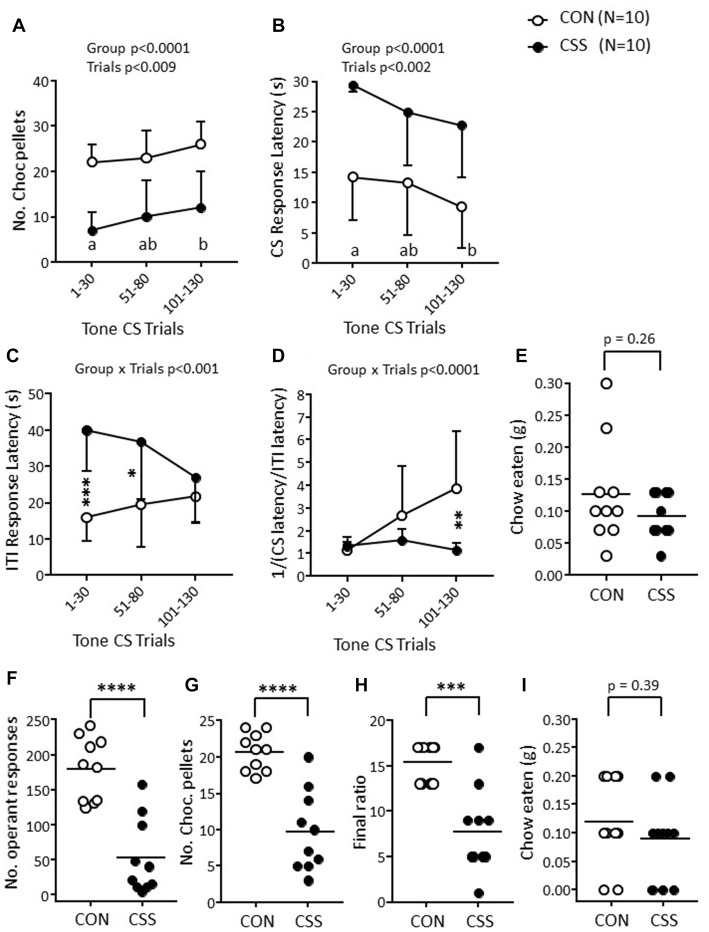
Effects of CSS on days 1–15 on reward-directed behavior in Experiment 3. (A–D) Scores for the first 30 trials per session in the RST on days 16–18: (A) Number of sucrose pellets obtained. (B) Mean response latency to a tone CS (maximum duration 30 s) associated with pellet availability. (C) Mean response latency in the inter-trial intervals (ITI, 50 ± 30 s) between successive CS. (D) Mean CS/ITI reciprocal ratio. Values are overall mean ± SD. Significant statistical effects indicated were obtained with mixed factorial ANOVA; *p < 0.05, **p < 0.01, ***p < 0.001, in post hoc tests of single sessions following Group × Trial interaction. (E) Scatter plot and overall mean for the mean weight of chow eaten during the three test session; p value is for the unpaired t-test. (F–I) Scores for the EVT on day 20, using a steep PRS. (F) Number of operant responses. (G) Number of chocolate pellets earned. (H) Final ratio attained. (I) Weight of chow eaten during the session. Graphs are scatter plots and mean values per group. Significant statistical effects indicated were obtained with unpaired t-tests; ***p < 0.001, ****p < 0.0001.